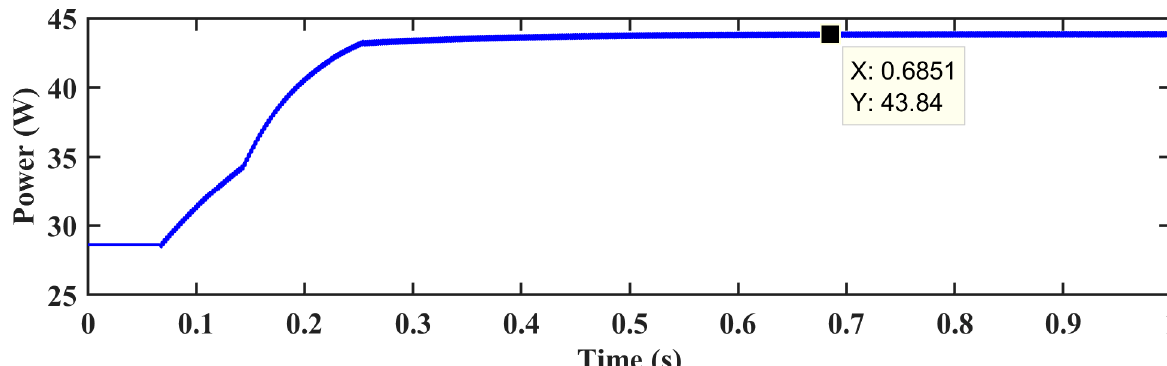
Figure 20. PSO-GRNN tracked power.